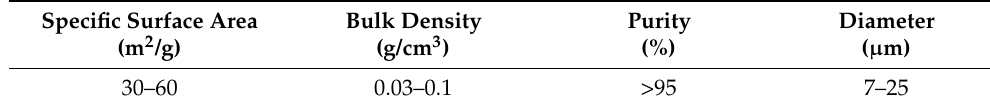
Table 2. Properties of graphene nanoplatelets (GNPs).